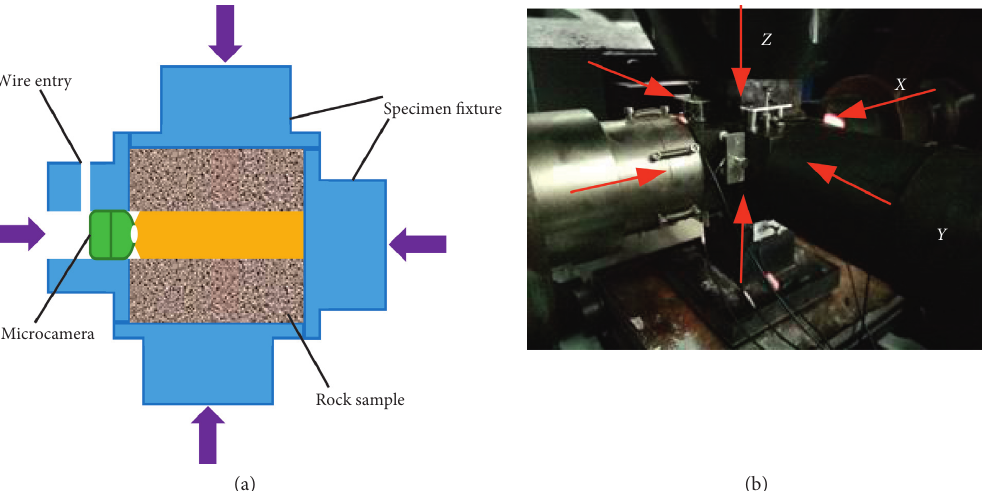
Figure 6: Real-time video monitoring of the internal structure failure of three-dimensional loading rock samples: (a) schematic diagram of the installation of the miniature camera and (b) schematic diagram of the triaxial loading.